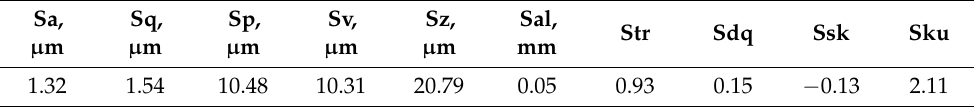
Figure 2. Topography of the DC04 steel sheet. Table 2. Basic surface roughness parameters of the DC04